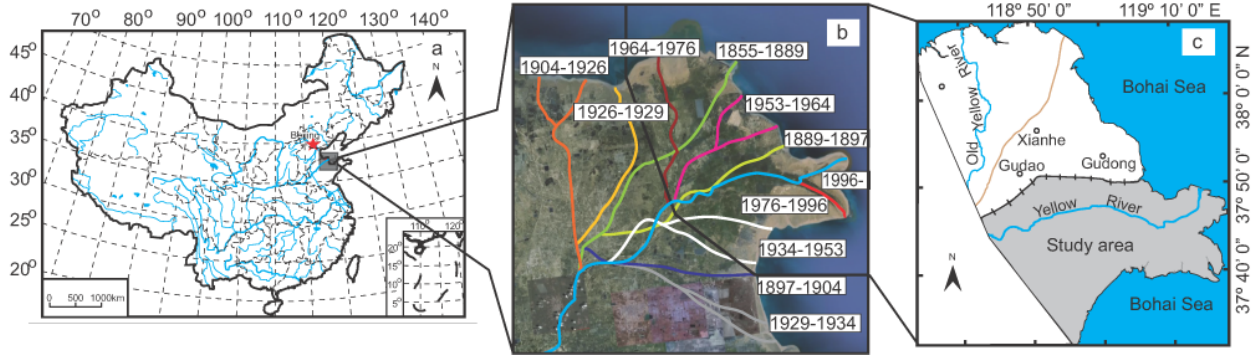
Fig. 1. Location map of modern Yellow River Delta (a) , history changes of river channel ( b , modified after Xue, 1993) and study area (c)